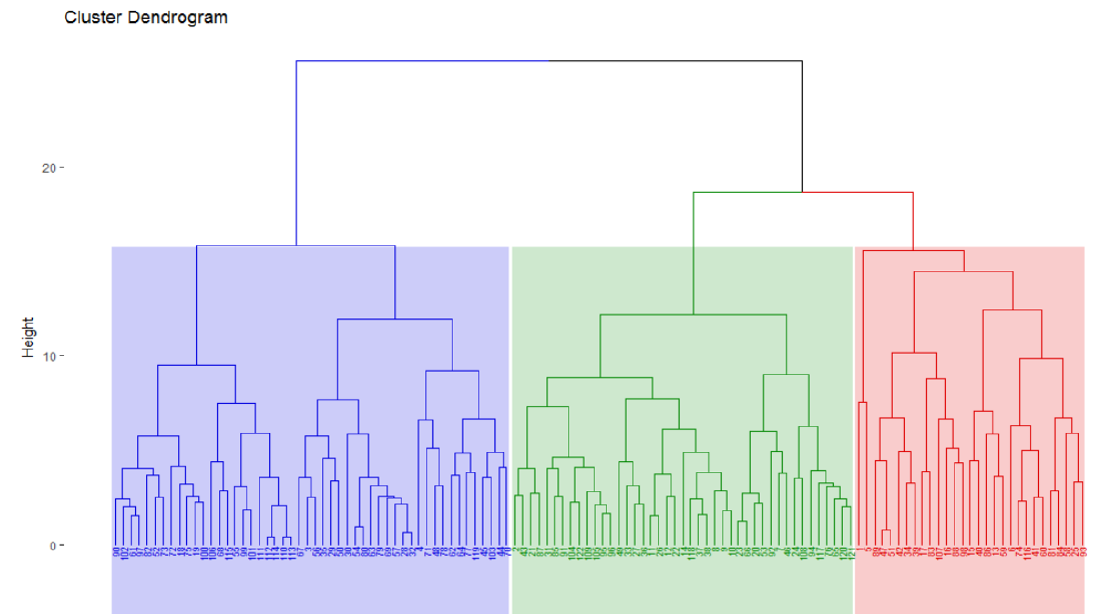
Figure 3. Visualization of the optimal number of clusters. The black, green, and red clusters represent the patient’s low, medium, or high prioritization.